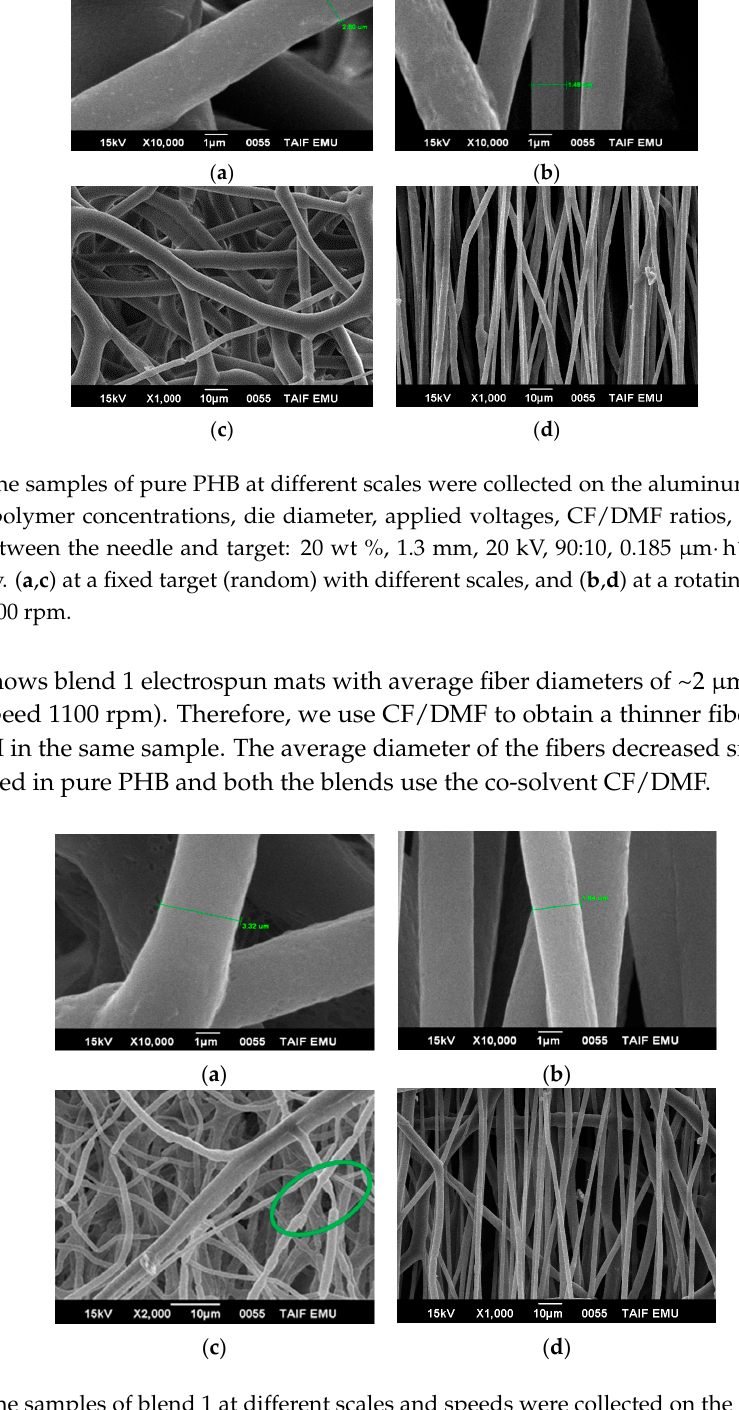
Figure 3. The samples of blend 1 at different scales and speeds were collected on the aluminum foil with the following polymer concentrations, die diameter, applied voltages, CF/DMF ratios, flow rate, and distance between the needle and target: 25 wt %, 1.3 mm, 20 kV, 90:10, 0.185 µm ⋅ h − 1 and 20 cm, ( a , c ) at fixed target (random); ( b , d ) at a rotating drum with a speed of 1100 rpm, respectively. The aligned electrospun fibers of pure PHB (Figure 2) and blend 1 showed no signs of necking during take-up at higher speed rotation compared with lower speeds. The average electrospun fiber